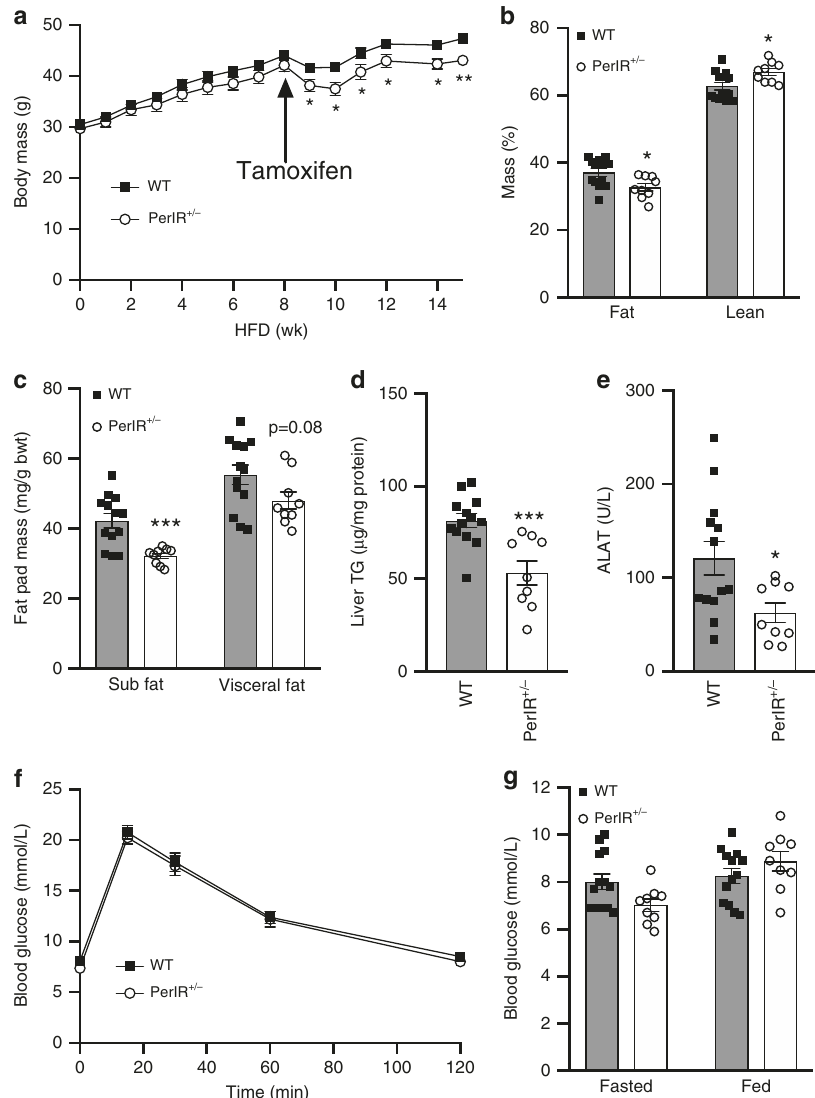
Fig. 5 Induction of partial peripheral tissue IR disruption following high-fat diet feeding lowers hepatic lipid content without impairing glucose tolerance. Following 8 weeks of high-fat diet (HFD) feeding, mice were treated with tamoxifen and body mass a body composition b , c , hepatic lipid content d and plasma ALAT e were determined, and glucose homeostasis assessed via glucose tolerance test f and blood glucose measurement g 6 – 7 weeks later. Results are shown as means ± SE, with n ’ s represented as individual data point ’ s in fi gures. For body weight and GTT n = 13 for WT and 9 for PerIRKO + / − . Signi fi cance was determined using two-tailed student ’ s t test; * p < 0.05, ** p < 0.01, and *** p < 0.001 vs